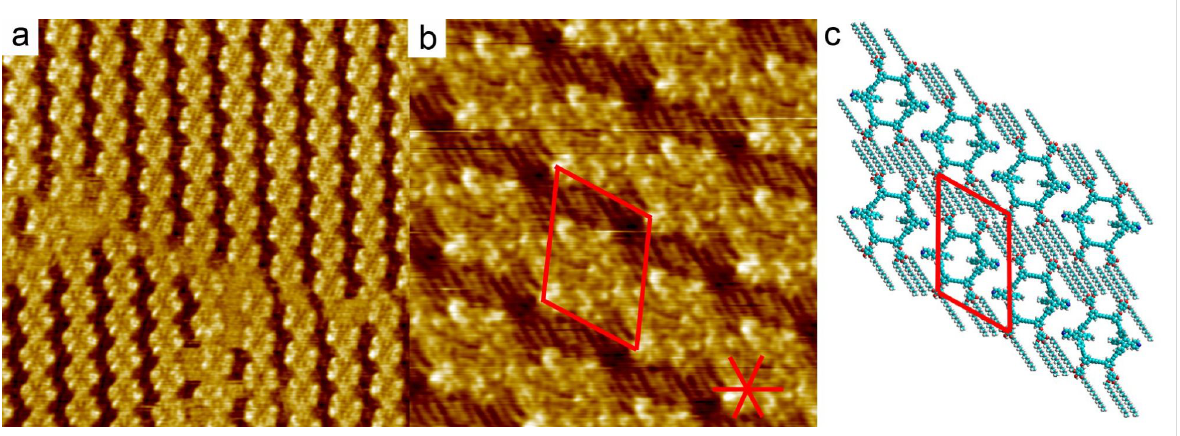
Figure 2: STM images and tentative molecular packing model of 1 self-assembled at the TCB/graphite interface. The unit cell parameters are a = 5.5 ± 0.1 nm, b = 4.4 ± 0.2 nm, γ = 68 ± 2°. a) 47.7 nm × 47.7 nm, i T = 49 pA, V S = − 520 mV. b) High resolution STM image, 16.7 nm × 16.7 nm, i T = 30 pA, V S = − 680 mV, the unit cell and the orientations of the main crystallographic directions of the underlying graphite surface are indicated in red. c) Schematic representation of the tentative packing model with the corresponding unit cell. Based on the STM contrast, on measurements of the area available for adsorption of alkyl chains, and on the ideal periodicity for physisorbed alkanes on graphite [18,19], it can be concluded that only eight out of twelve alkyl chains are adsorbed on graphite.